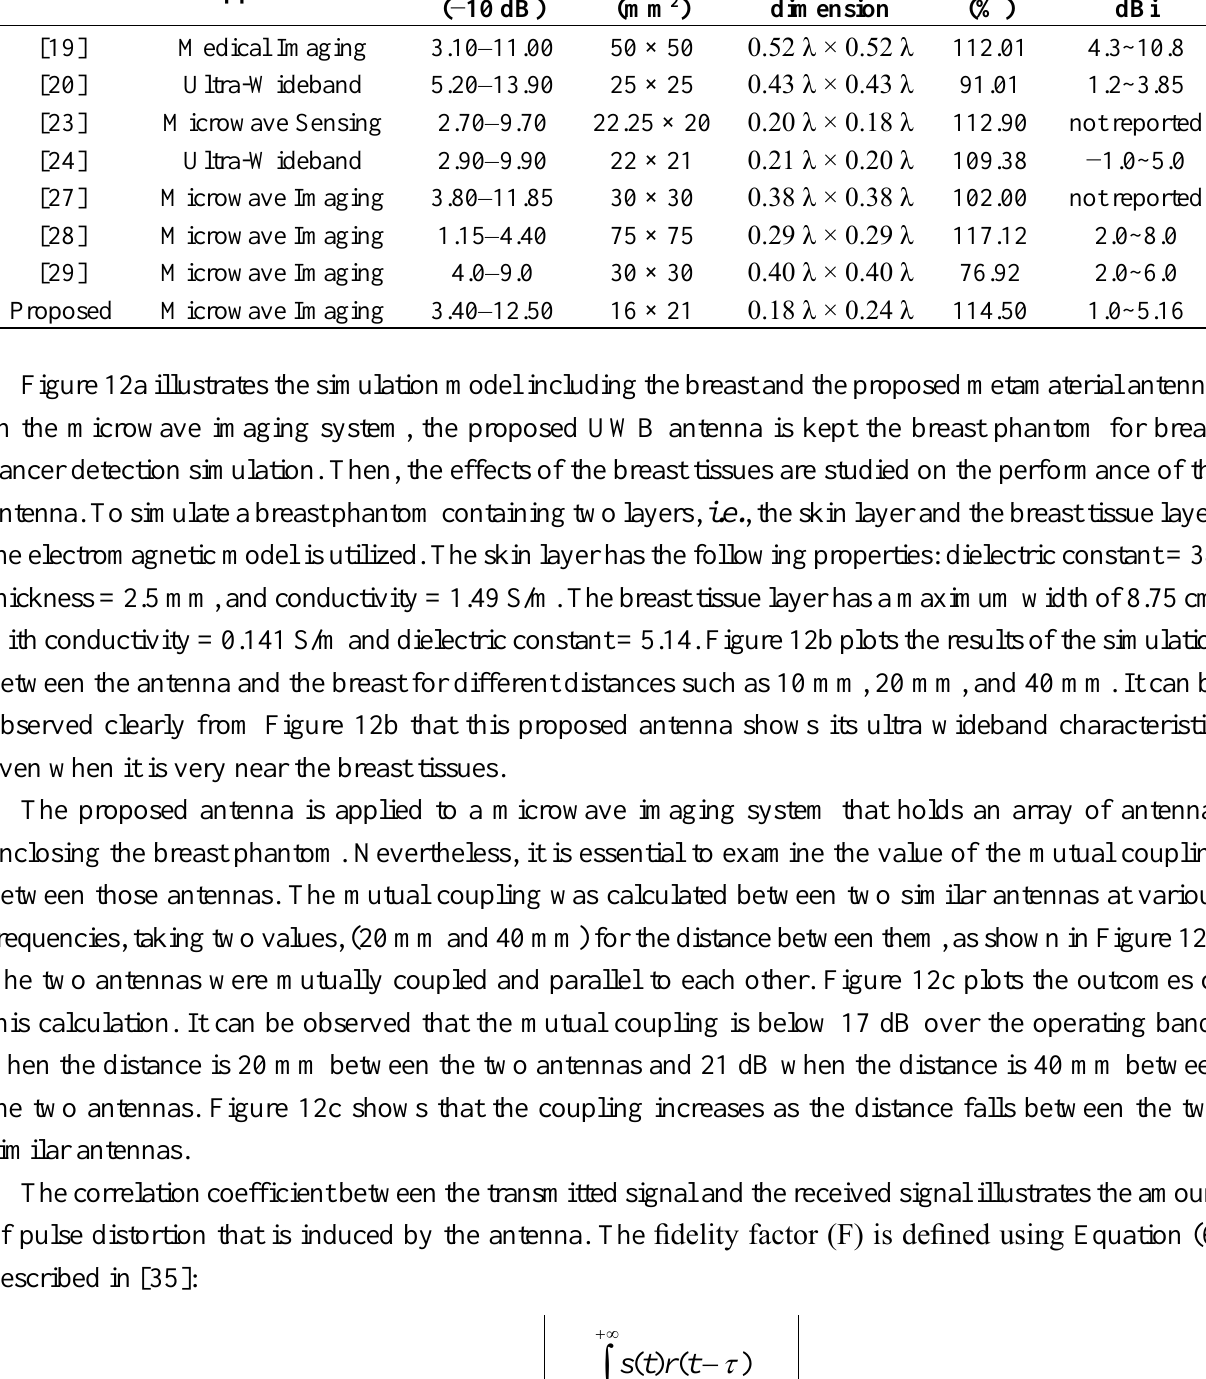
Table 4. Comparison of existing antennas with the proposed UWB metamaterial antenna.